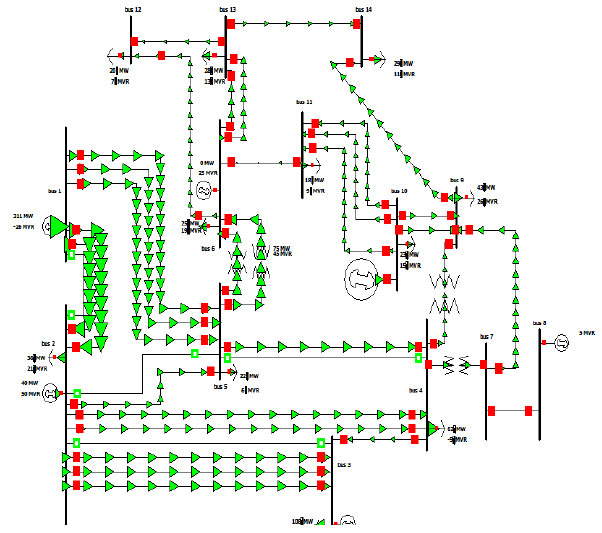
Fig8. New network after optimization